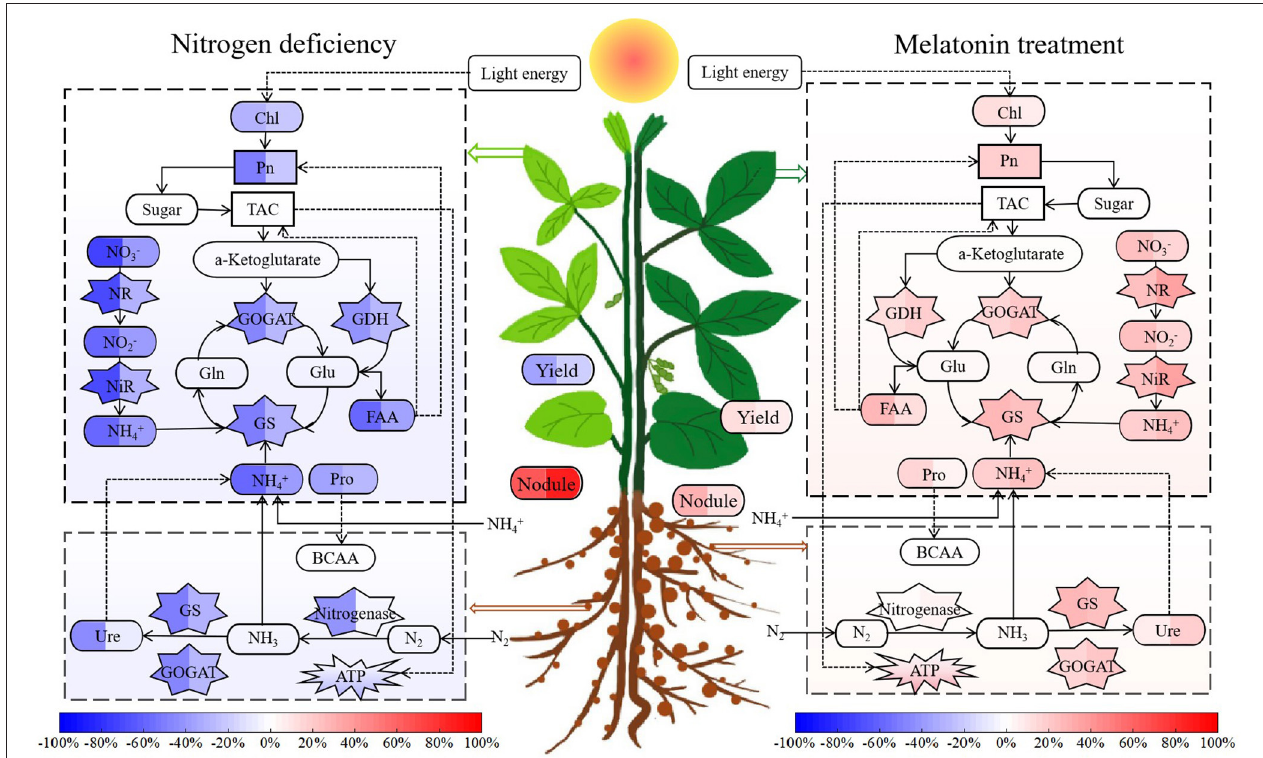
FIGURE 14 | The left of the schematic model displays the changes in physiological metabolism and yield of soybean under 0N and LN treatments compared with the control. The left data in the heat map were taken from 0N and the right data were taken from LN, while the right of the schematic model shows the regulatory effect of MT application at V3 stage on carbon and nitrogen metabolism balance and yield compared with no MT treatment under 0N and LN supply levels. The left data in the heat map were taken from 0N + V3MT and the right data were taken from LN + V3MT. The blue depth indicates the degree of decrease, and the red depth indicates the degree of increase. TAC, tricarboxylic acid cycle; BCAA, branched-chain amino acid. The abbreviated meaning of other indices is the same as in Figure 13